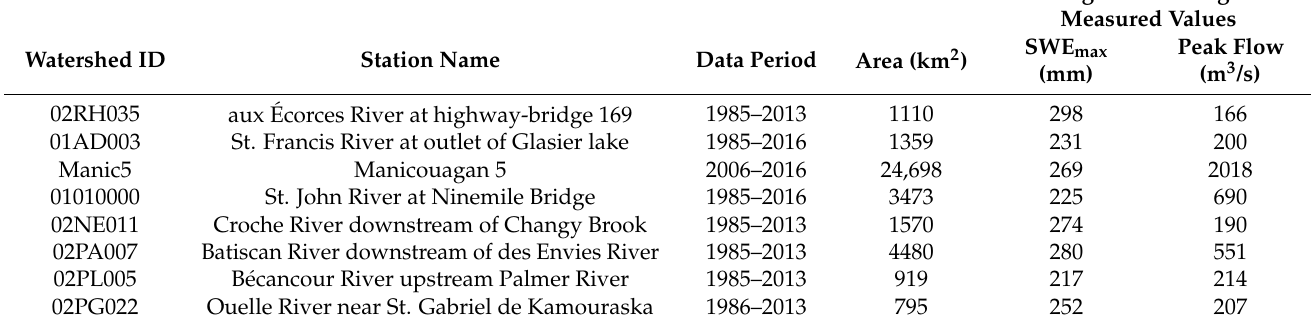
Table 1. Physiographic and hydrometeorological data of the watersheds under